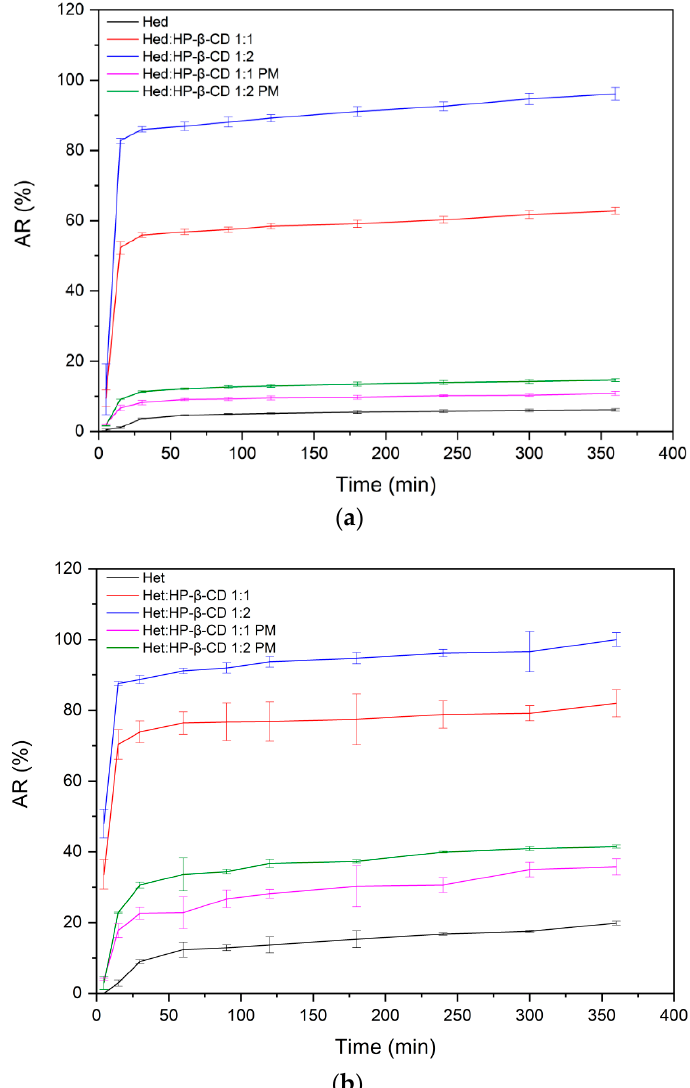
Figure 5. The results of dissolution rate studies of Hed ( a ) and Het ( b ) systems and physical mixtures.